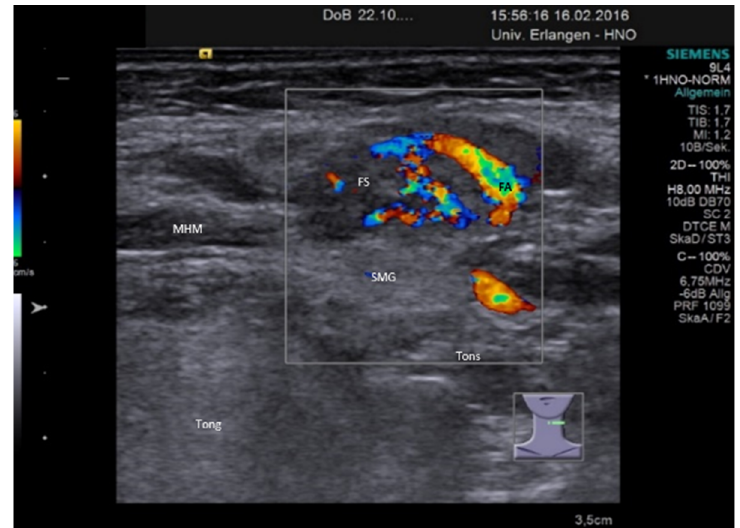
Figure 2. Focal fibrosis in a left SMG. The parenchyma is partially hypoechoic changed. In contrast to any tumor-like or tumorous lesions, the tissue structure is not changed. The perfusion pattern is regular and not different to the pathological and or the residual uninvolved gland. Abbreviations: SMG, submandibular gland; MHM, mylohyoid muscle; Tong, tongue; Tons, tonsil; WD, Wharton’s duct; FA, facial artery; FS, focal sialadenitis.